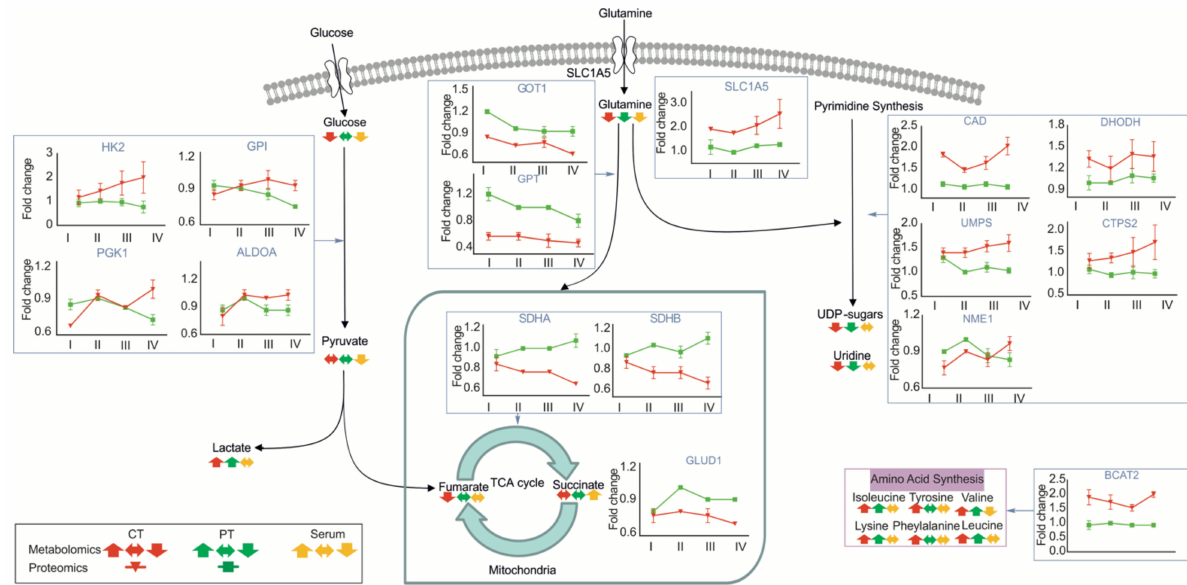
Figure 6. Schematic overview of growing human hepatocellular tumors undergoing a global metabolic reprogramming and proteomic changes. Metabolic genes and metabolites involved in glycolysis, the tricarboxylic acid (TCA) cycle and pyrimidine synthesis. Red line represents tumor tissues, and green line represents peritumoral tissues in proteomics. Red arrow represents tumor tissues, green arrow represents peritumoral tissues and yellow arrow represents the serum in the